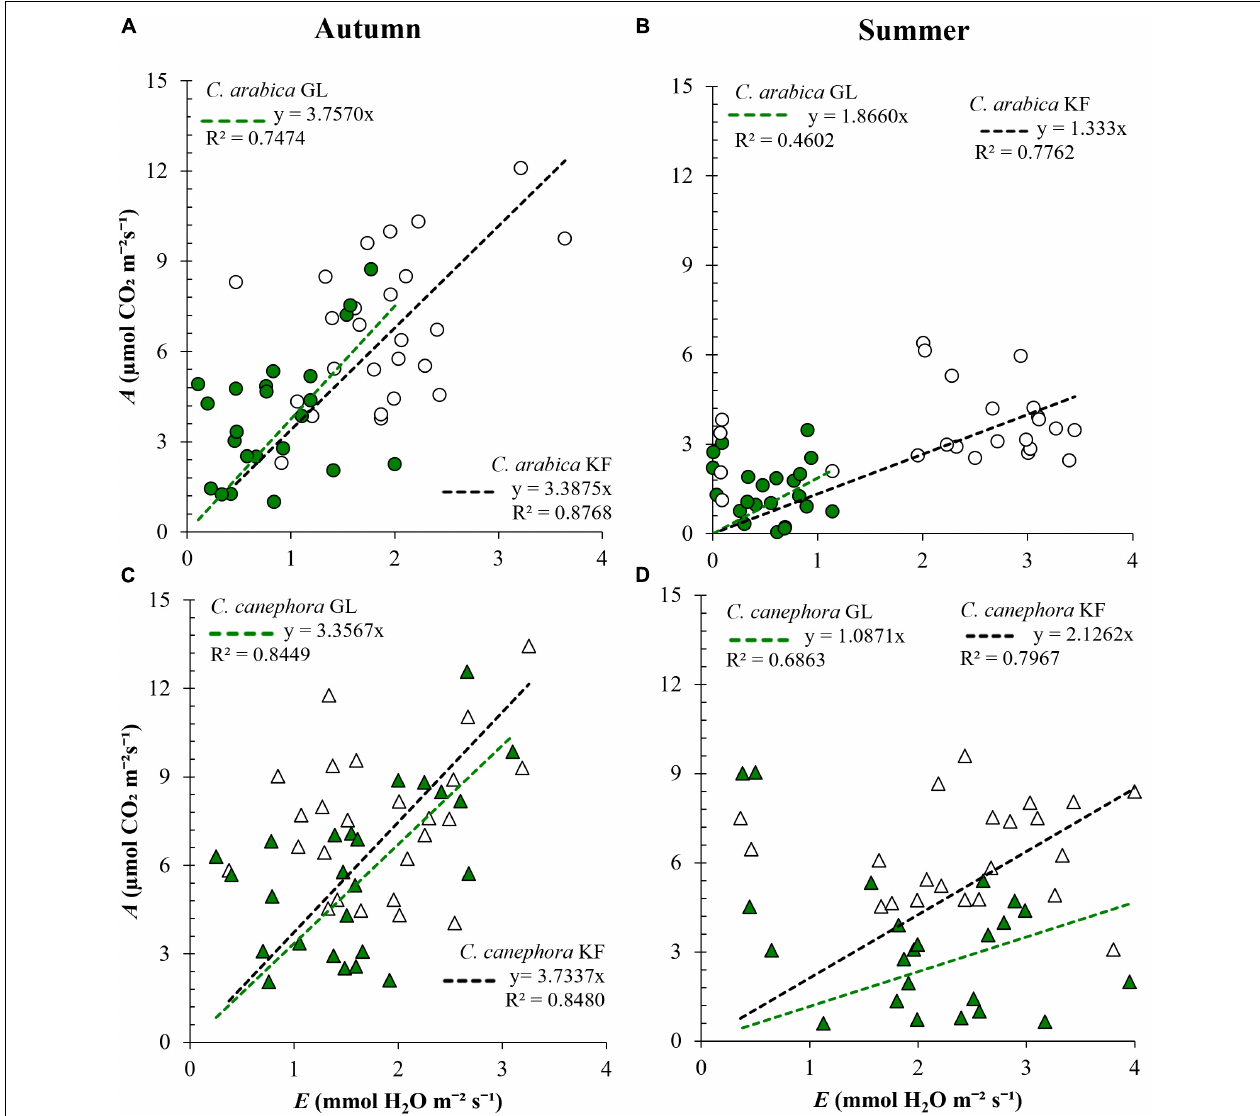
FIGURE 2 | Instantaneous water use efficiency (WUE, µ mol mmol - 1 ) in young plants of (A,B ) Coffea arabica and (C,D) C. canephora protected with kaolin film (KF) and not protected (GL), during a transference of coffee seedlings from nursery to the full sunlight in autumn and